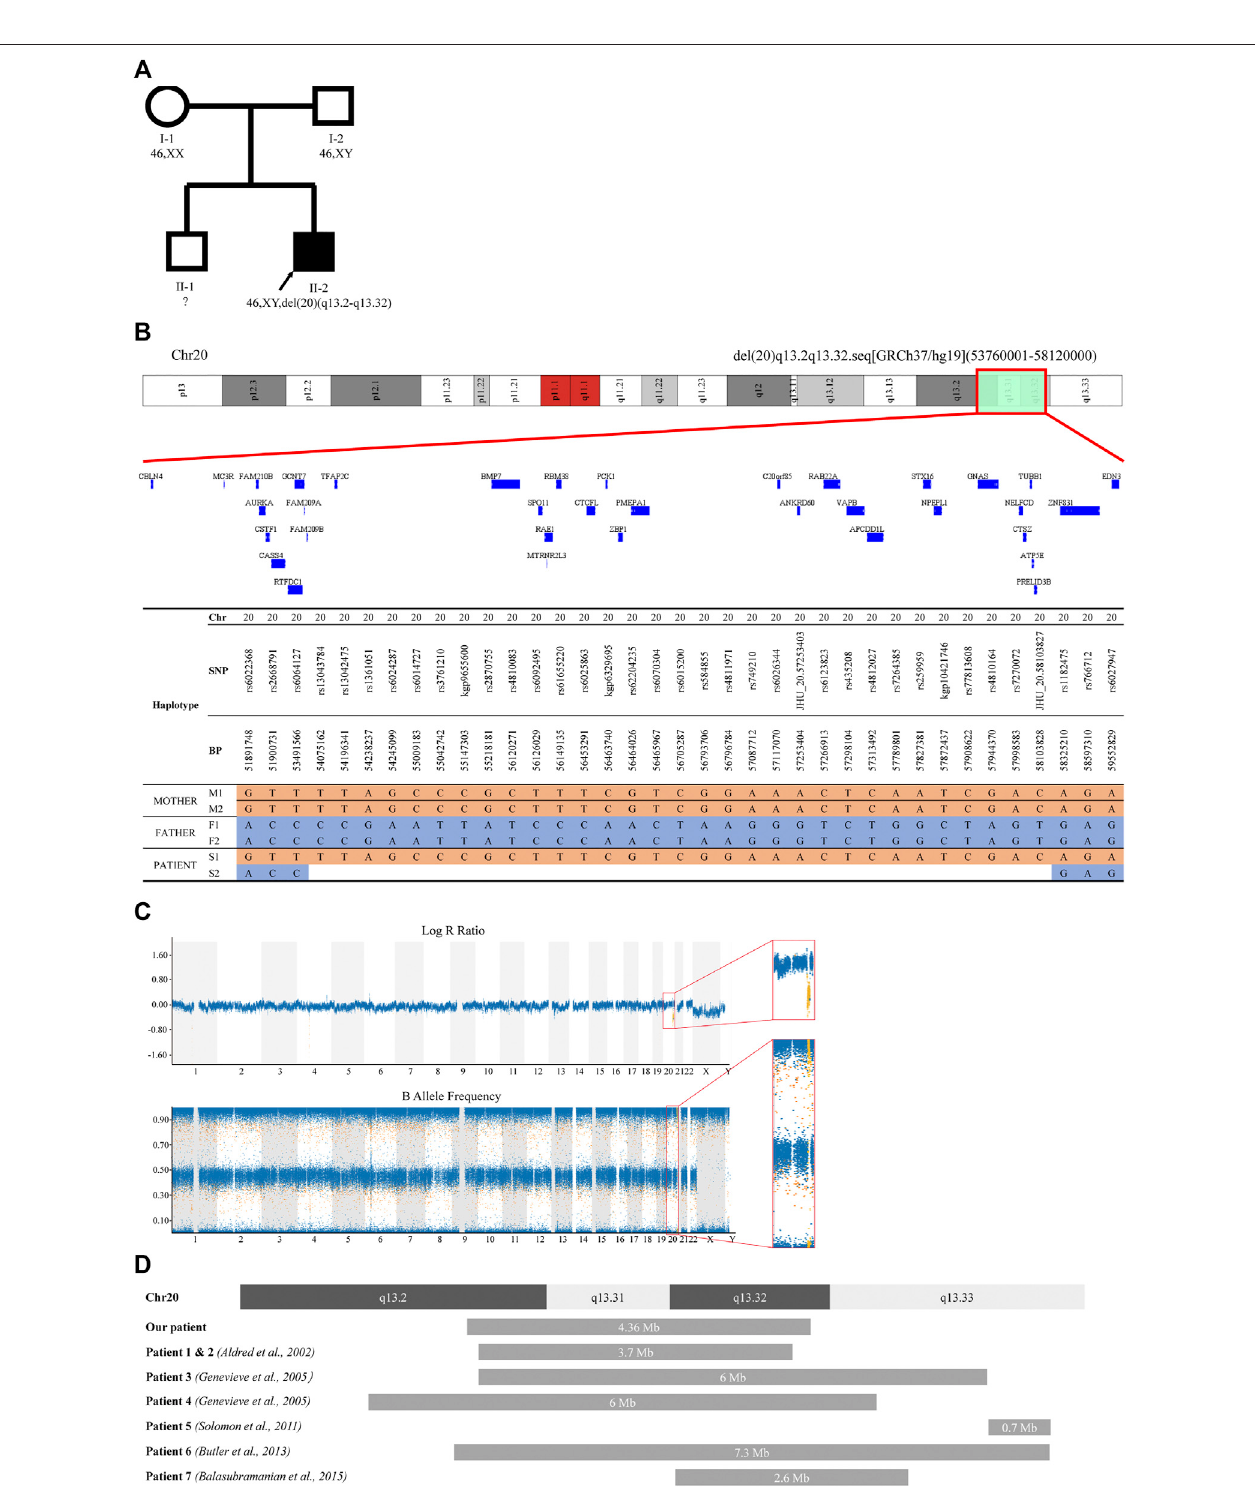
FIGURE 3 | Pedigree and CNV analysis of the family. (A) Familial pedigree showing the phenotype and genotype of the family. Proband (II-2) had a heterozygous deletionofchromosome20q13.2-q13.32.Thegenotypeofproband ’ selderbrother(II-1)wasnotassessed. (B) Aschematicstructureofthedeletedregionsdetectedin thepatient(II-2)andcomparisonwithhisparents(I-1andI-2).OnlySNPpositionsatwhichbothparentswerehomozygousforoppositealleleswereshowed. (C) Ballele frequency plot and log R ratio plot of the patient ’ s SNP array result. (D) A schematic diagram of reported deletions around 20q13.32 compared with the deletion identi fi ed in this